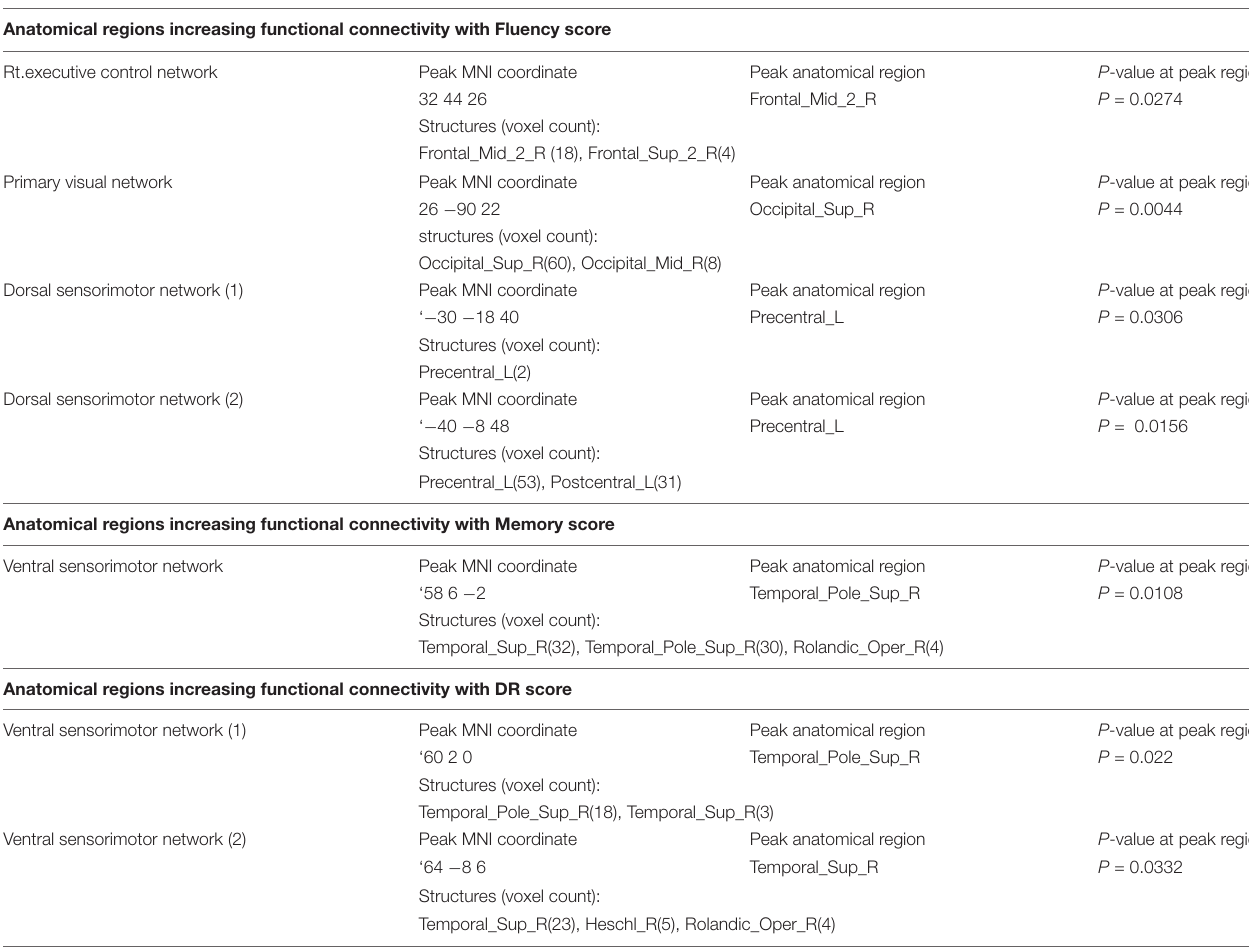
TABLE 7 | Anatomical regions increasing functional connectivity with cognitive score in the canonical RSNs. Anatomical regions increasing functional connectivity with Fluency score Rt.executive control network Peak MNI coordinate Peak anatomical